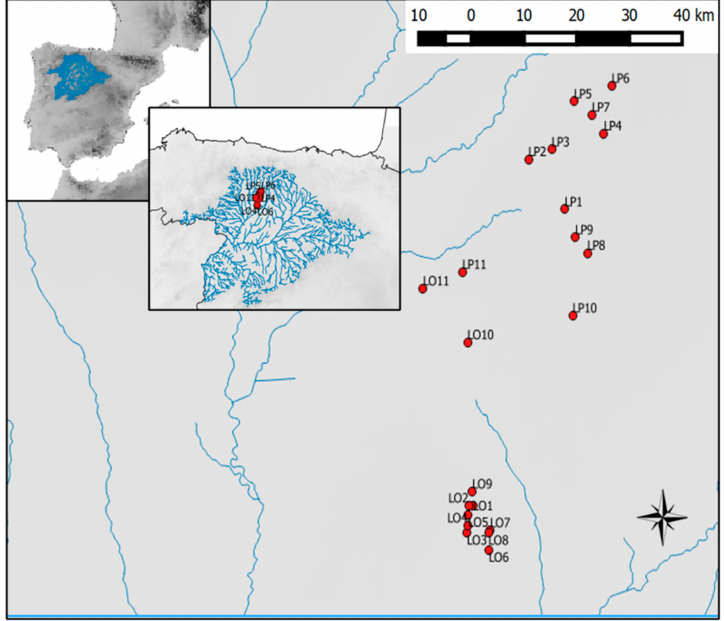
Figure 1. Study area showing the location of the 22 studied ponds in the Duero River basin (NW